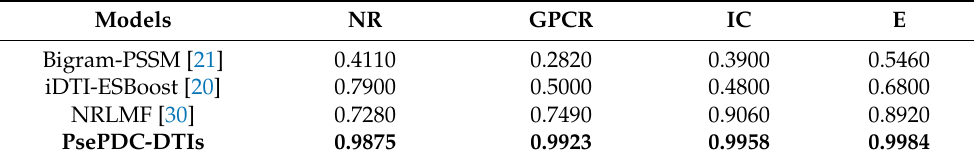
Table 2. Performance comparison of different approaches on benchmark datasets in terms of AUPR.